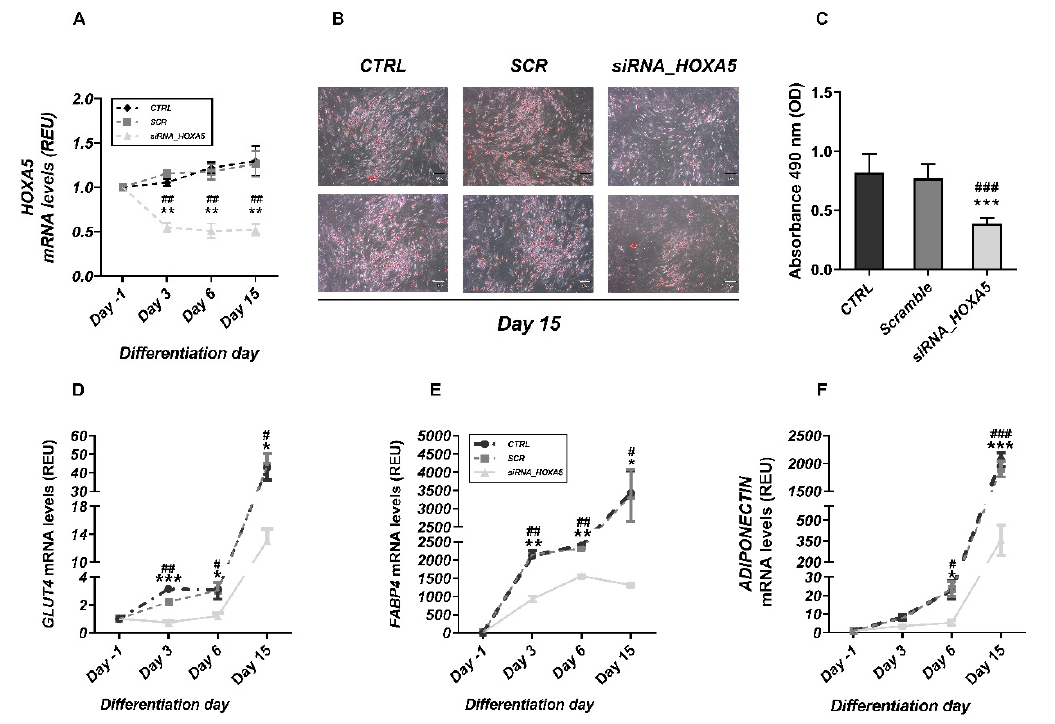
Figure 1. Effect of HOXA5 silencing on the differentiation of human preadipocytes. ( A ) HOXA5 mRNA levels were measured by qPCR at different time points during differentiation in cells treated with HOXA5 -specific siRNA ( siRNA_HOXA5 ), scrambled siRNA ( SCR ), or control (CTRL). All data are presented as means ± SD of 3 independent experiments. Statistical significance was tested by one-way ANOVA followed by Tukey’s multicomparison test at each indicated time. ** p < 0.01 versus CTRL ; ## p < 0.01 versus SCR . ( B ) CTRL cells and cells treated with SCR or siRNA_HOXA5 , at differentiation day 15, were stained with Oil Red O and then subjected to phase contrast microscopy. Representative fields are presented. ( C ) The lipid quantitation was determined by measuring absorbance at 490 nm as described in the Materials and Methods section. Expression levels of GLUT4 ( D ), FABP4 ( E ), and ADIPONECTIN ( F ) were assessed by qPCR at the indicated times during differentiation. All data are presented as means ± SD of 3 independent experiments. Statistical significance was tested by one-way ANOVA followed by Tukey’s multicomparison test at each indicated time point: * p < 0.05; ** p < 0.01; *** p < 0.001 for comparison versus CTRL ; # p < 0.05, ## p < 0.01, ### p < 0.001 versus SCR .